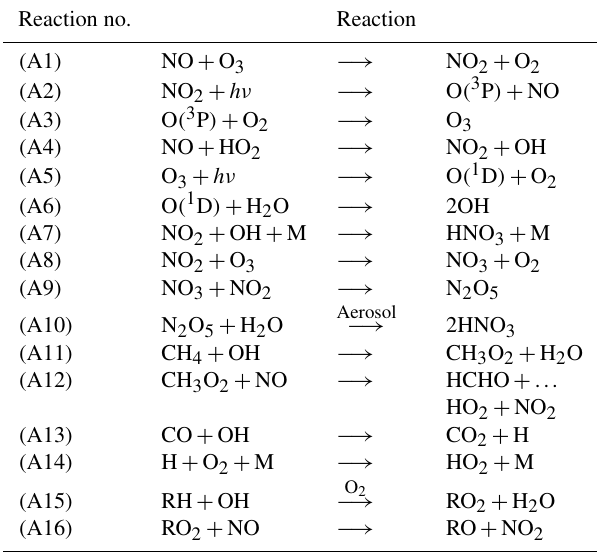
Table 3. Dominant O 3 / NO y / HO x reaction pathways in APCEMM. Reaction